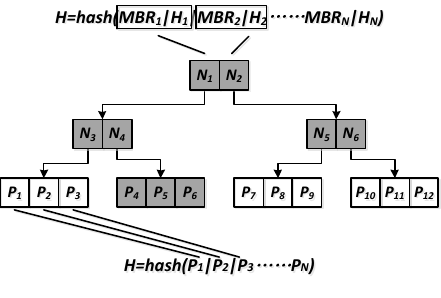
The MR-tree combines concepts from MB-tree and